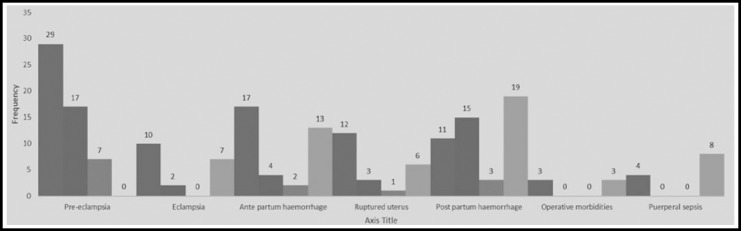
Management out come.